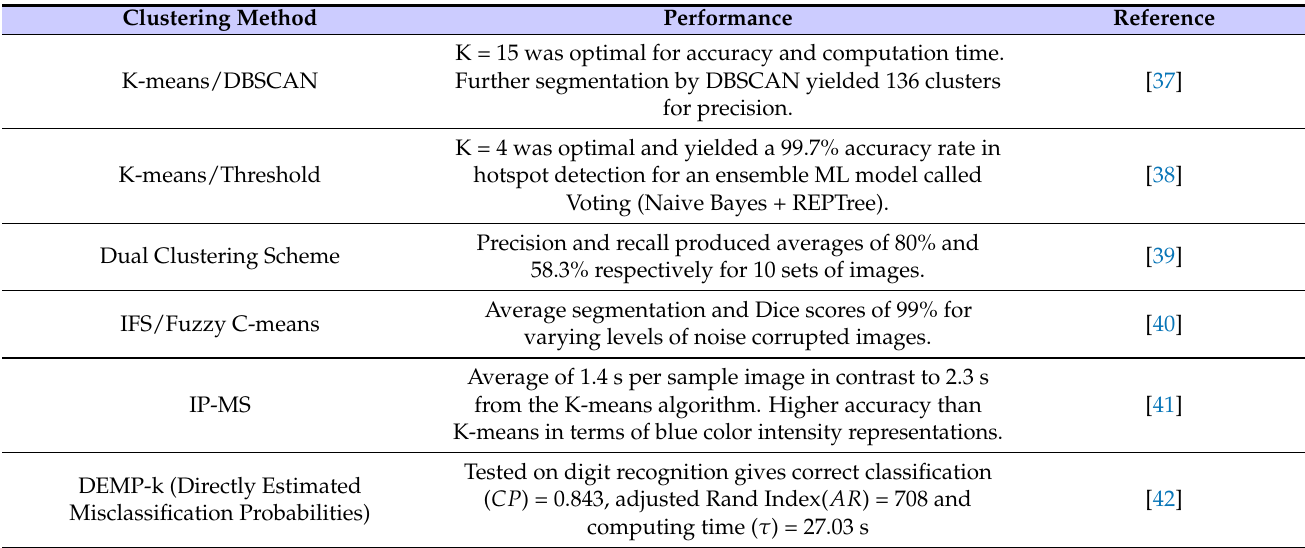
Table 2. State-of-the-art image clustering